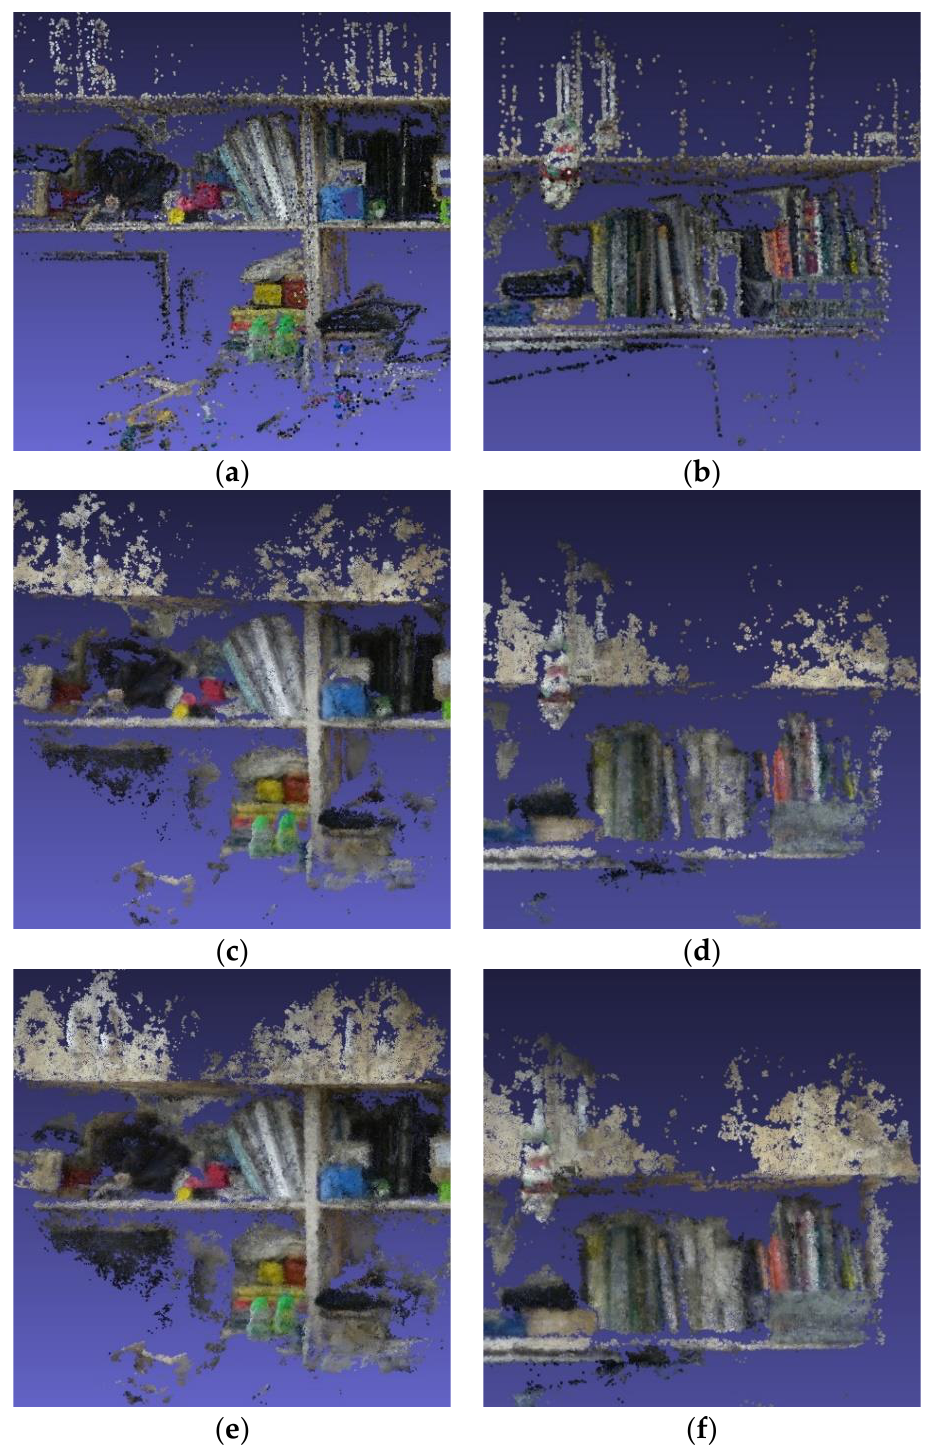
Figure 19. Detailed 3D reconstruction results of the different methods. ( a , b ) Traditional method; ( c , d ) MVSNet; ( e , f ) CES-MVSNet.